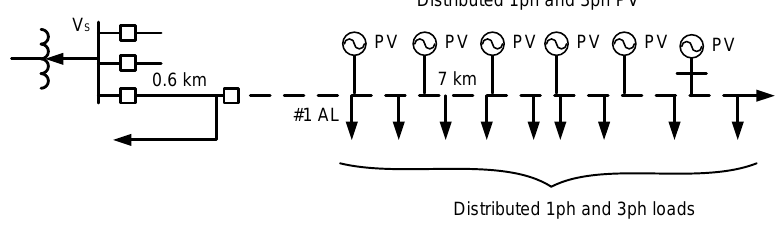
Figure 4. Simplified illustration of the feeder under analysis.